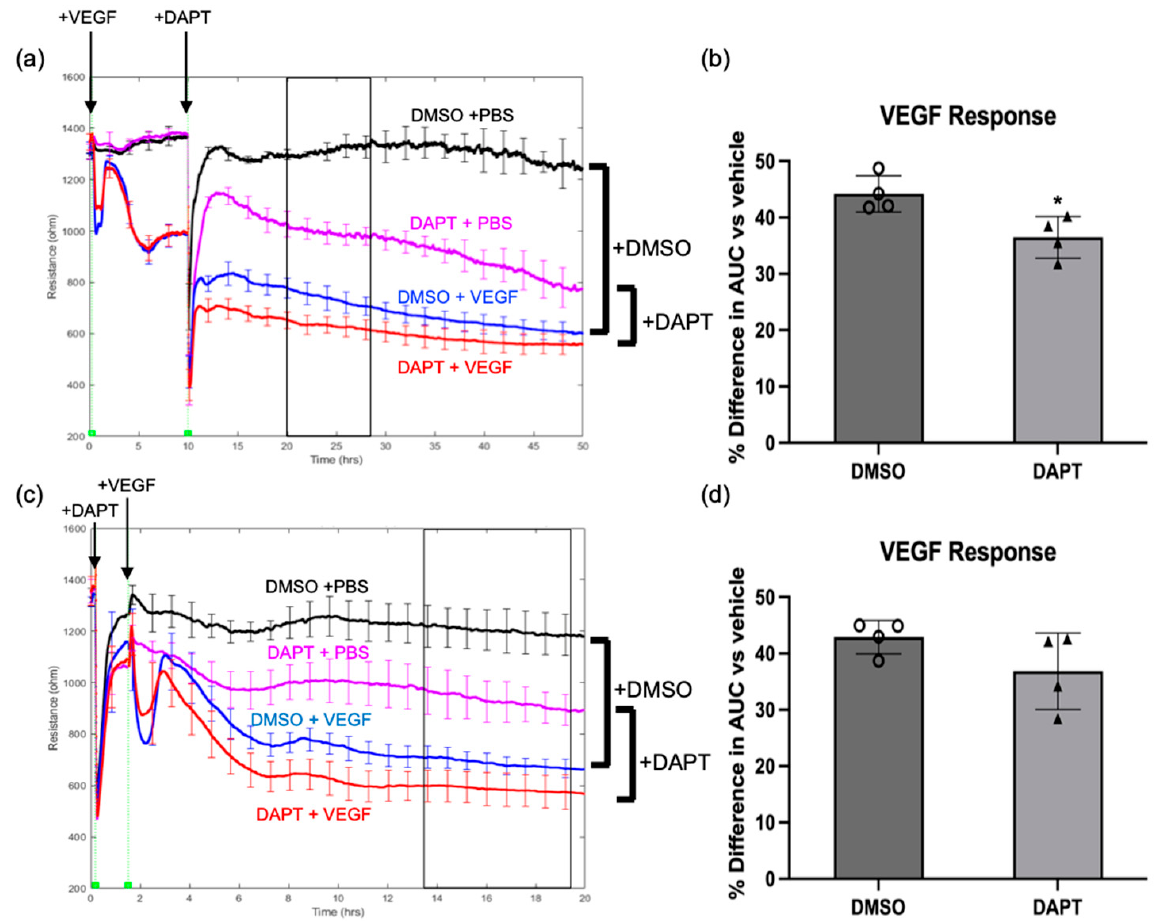
Figure 3. Notch signaling was required for VEGF to sustain barrier relaxation. ( a ) Electric cell-sub- strate impedance sensing (ECIS) of con fl uent monolayers of normal-glucose HRECs was measured brie fl y before the addition of VEGF (2 nM) or vehicle (PBS) and the resistance is presented in ohms. Resistance was measured for 10 h before the addition of DAPT (10 uM) or vehicle (DMSO) at time indicated by arrows. The box represents the time period used for area under curve (AUC) calcula- tion. ( b ) The percent di ff erence in the resistance AUC for HRECs stimulated with VEGF, then given DAPT or vehicle (DMSO) 10 h later. Percent di ff erence was calculated relative to HRECs that re- ceived VEGF vehicle (PBS), then DAPT or DMSO 10 h later. AUC was calculated for the period 12– 18h after DAPT was added. While the e ff ect of DAPT on extent of barrier relaxation during the 12– 18 h time period was not statistically signi fi cant in two other experiments, these replicate experi- ments showed the same trend. Importantly, the e ff ect of DAPT was statistically signi fi cant in all 3